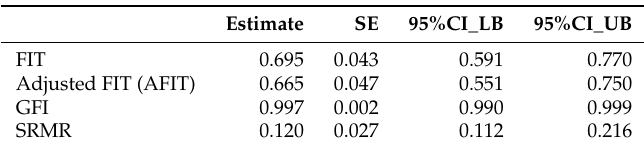
Table 8. Model fit.